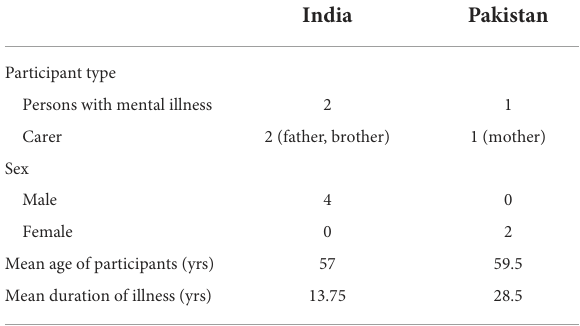
TABLE 2 Socio-demographic profile of patient and caregiver